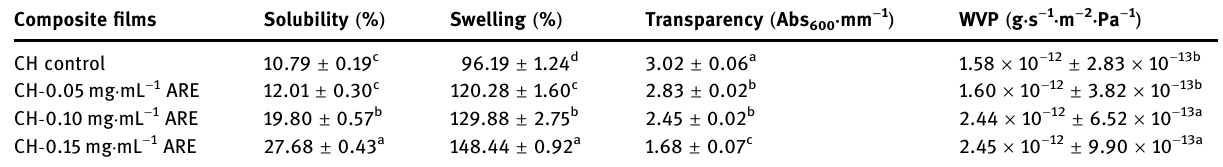
Table 2: Solubility, swelling, transparency, and WVP values of CH/ARE composite fi lms containing di ff erent concentrations of ARE Composite fi lms